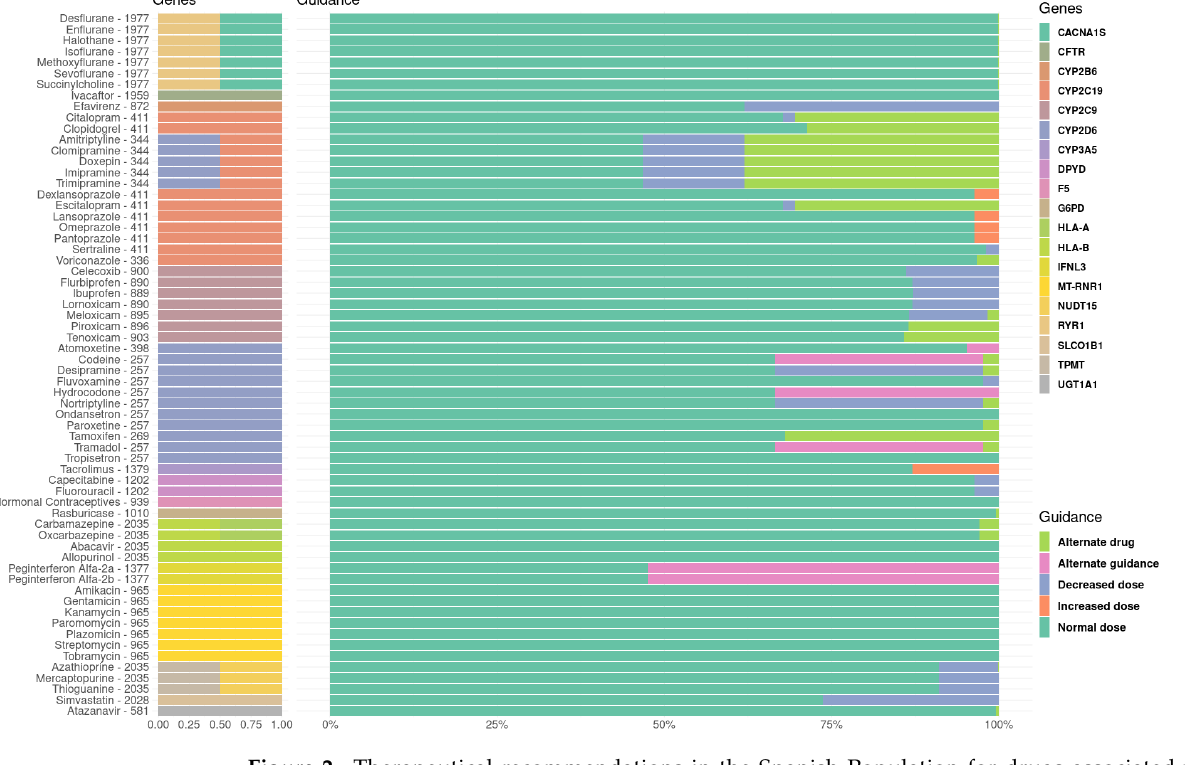
Figure 2 . Therapeutical recommendations in the Spanish Population for drugs associated with PharmGKB level 1A genes. Drugs with available CPIC guidelines and associated with the 21 PGx genes categorised as level 1A in the PharmGKB database are included in the figure The number of individuals included for each drug is depicted next to the corresponding drug. The genes associated with the therapeutical prescription of the drugs are depicted in colours next to the corresponding drug. The proportion of the Spanish population is depicted with a normal dose (green), decreased dose (blue), increased dose (orange), alternate guidance (pink) and alternate drug (light green). No-call recommendations have been removed for visual purposes, but a full list of the recommendations identified is provided in Table S6.